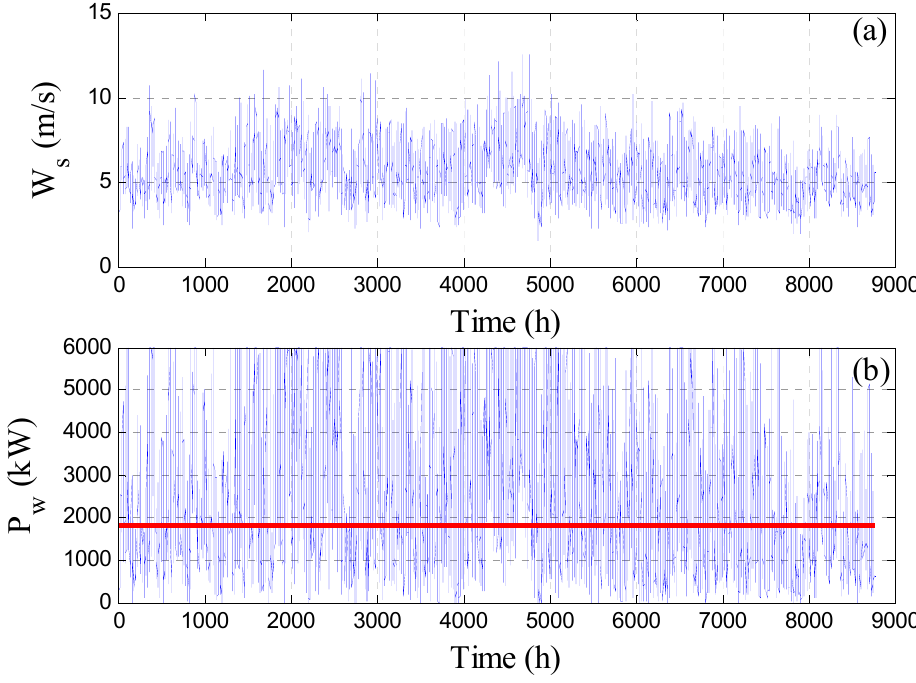
Figure 1. Annual wind property profile for the site ( a ) wind speed, ( b ) generated power.